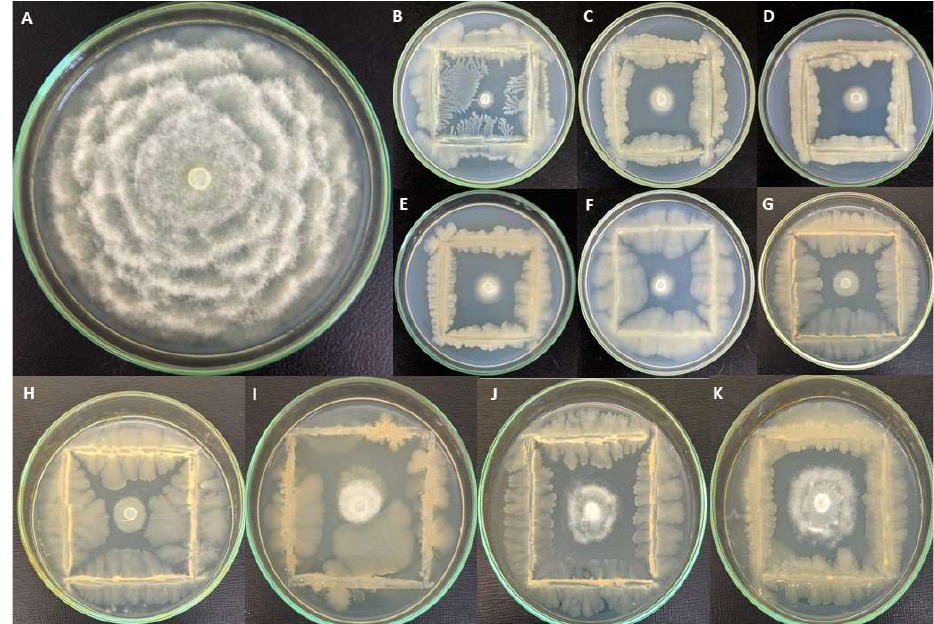
Figure 1. In vitro confrontation revealing antagonistic activity of bacterial strains against P. schmitthenneri on PDA medium after 6 days of incubation at 25 °C. ( A ) control; ( B ) ACBC1; ( C ) ACBC2; ( D ) ACBP1; ( E ) ACBP2; ( F ) SF14; ( G ) K3-7; ( H ) Bel3-4; ( I ) TG6; ( J ) BM3-5; ( K ) GH1-5. Table 2. The in vitro inhibition rates (%) of the P. schmitthenneri mycelial growth after 6 days of incubation at 25 °C in darkness.